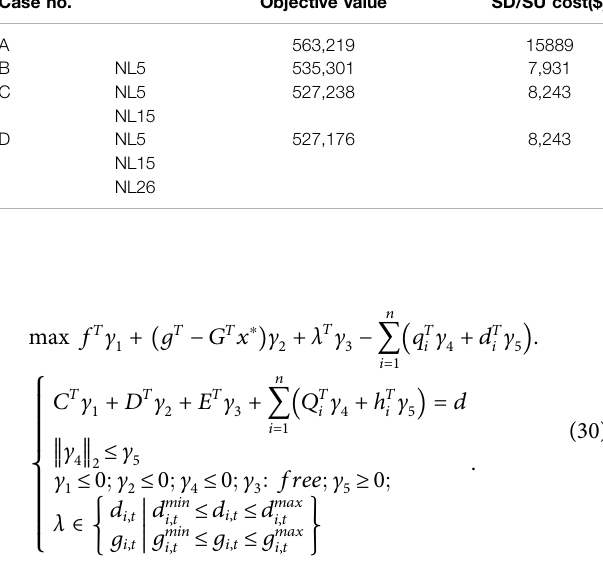
TABLE 1 | Dispatch performance with different numbers of the DPFC. Case no.